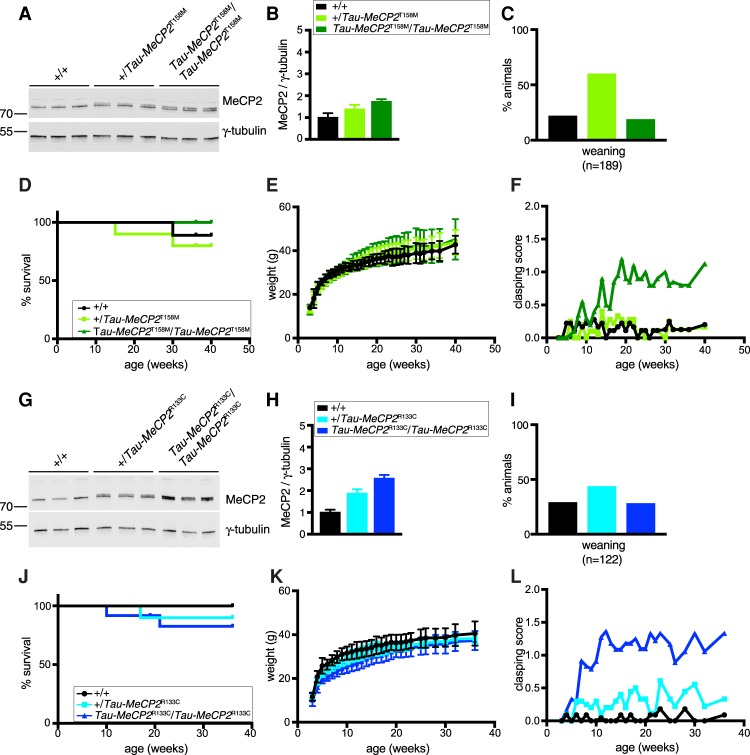
Overexpression of MBD mutants in addition to wild-type MeCP2 is deleterious. (A) Western blots of three brains of animals heterozygous and homozygous for Tau-Mecp2[T158M] and wild-type littermates (males, 7 wk) probed for MeCP2 and γ-tubulin. (B) Quantification of blots shown in A (mean and standard deviation). Genotypes are +/+ (black), +/Tau-Mecp2[T158M] (light green), and Tau-Mecp2[T158M]/Tau-Mecp2[T158M] (dark green). A two-tailed unpaired t-test was used for statistical analysis. P = 0.0748 for wild type versus heterozygous; P = 0.0053 for wild type versus homozygous. (C) Genotypes derived from Tau-Mecp2[T158M] heterozygous intercrossings observed at weaning. A χ2 test was used to test for normal Mendelian ratios of genotypes. P = 0.1554. (D) Survival of a cohort comprising +/+ (black; n = 9), +/Tau-MeCP2[T158M] (bright green; n = 10), and Tau-Mecp2[T158M]/Tau-Mecp2[T158M] (dark green; n = 10). A Mantel-Cox test was used to analyze survival. P = 0.5767 for wild type versus heterozygous; P = 0.2918 for wild type versus homozygous. (E) Body weights of the mice shown in D (mean and standard deviation). Two-way repeated measures of ANOVA were performed (weeks 3 and 40 were excluded, as not all animals were analyzed; one wild-type and two heterozygous animals that died were also excluded). n = 8 wild type; n = 8 heterozygous; n = 10 homozygous. Genotype effect: F(2,23) = 0.3047. P = 0.7403. (F) Clasping score of the mice shown in D. Two-way repeated measures of ANOVA were performed (weeks 3 and 40 were excluded, as not all animals were analyzed; one wild-type and two heterozygous animals that died were also excluded). n = 8 wild type; n = 8 heterozygous; n = 10 homozygous. Genotype effect: F(2,23) = 4.964. P = 0.0161. Overall scores are in Supplemental Figure S4G. (G) Western blots of three brains of mice heterozygous and homozygous for Tau-Mecp2[R133C] and wild-type littermates (males, 7 wk) probed for MeCP2 and γ-tubulin. (H) Quantification of blots shown in G (mean and standard deviation). The genotypes used were +/+ (black), +/Tau-Mecp2[R133C] (cyan), and Tau-Mecp2[R133C]/Tau-Mecp2[R133C] (dark blue). A two-tailed unpaired t-test was used for statistical analysis. P = 0.0028 for wild type versus heterozygous; P = 0.0002 for wild type versus homozygous. (I) Genotypes resulting from Tau-Mecp2[R133C] heterozygote intercrosses observed at weaning. Legend is as for H. A χ2 test was used to test for normal Mendelian ratios of genotypes. P = 0.6256. (J) Survival of a cohort comprising +/+ (black; n = 11), +/Tau-Mecp2[R133C] (cyan; n = 10), and Tau-Mecp2[R133C]/Tau-Mecp2[R133C] (dark blue; n = 12). This was analyzed using a Mantel-Cox test. P = 0.2943 for wild type versus heterozygous; P = 0.1560 for wild type versus homozygous. (K) Body weights of the mice shown in J (mean and standard deviation). Two-way repeated measures of ANOVA were performed (week 3 was excluded as not all animals were analyzed; one heterozygous and three homozygous animals that died were also excluded). n = 11 wild type; n = 9 heterozygous; n = 9 homozygous. Genotype effect: F(2,26) = 5.937. P = 0.0075. (L) Clasping score of the mice shown in J. Two-way repeated measures of ANOVA were performed (week 3 was excluded, as not all animals were analyzed; one heterozygous and three homozygous animals that died were also excluded). n = 11 wild type; n = 9 heterozygous; n = 9 homozygous. Genotype effect: F(2,26) = 16.6. P < 0.0001.